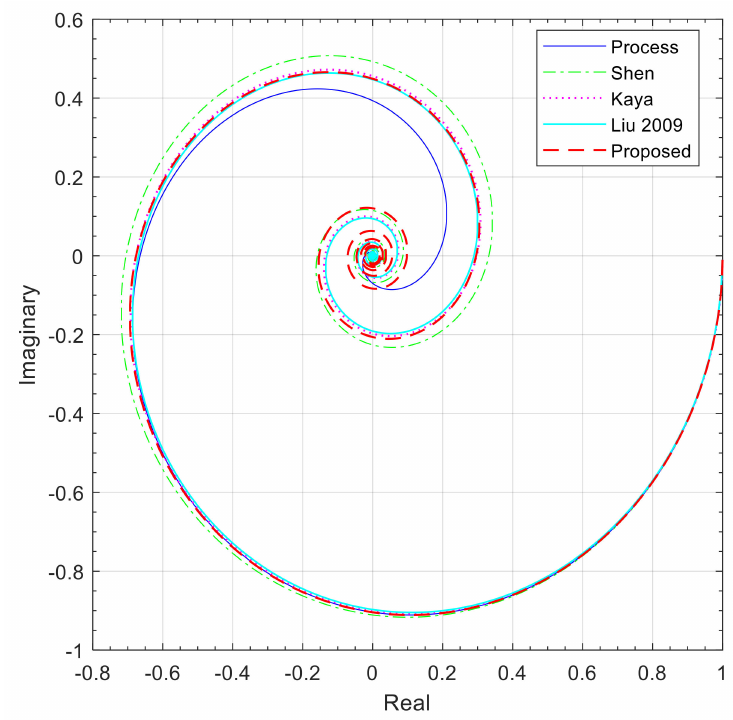
Figure 23. The Nyquist plots for process G P6